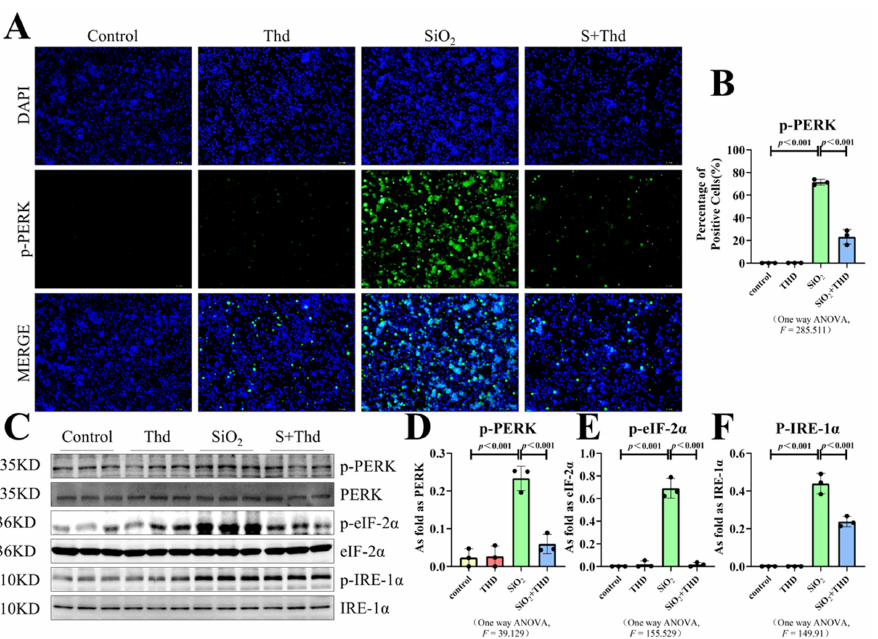
Figure 6. Thalidomide inhibited the ER stress signal in macrophages. ( A , B ) Expression of p-PERK in MH-S cells observed by IF staining (scale bar = 100 µm). ( C – F ) Protein expression of p-PERK, p-eIF-2 α , and p-IRE-1 α in MH-S cells treated with thalidomide, SiO 2 , and SiO 2 plus thalidomide measured by Western blot. Data are presented as the mean ± SD, n = 3 per group.